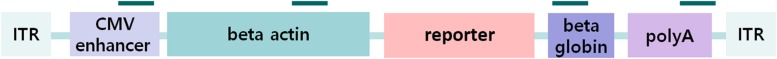
Schematic representation of annotated regions in AAVrh.10h vectors. The regions targeted by different assays are marked with short lines above the targeted gene.